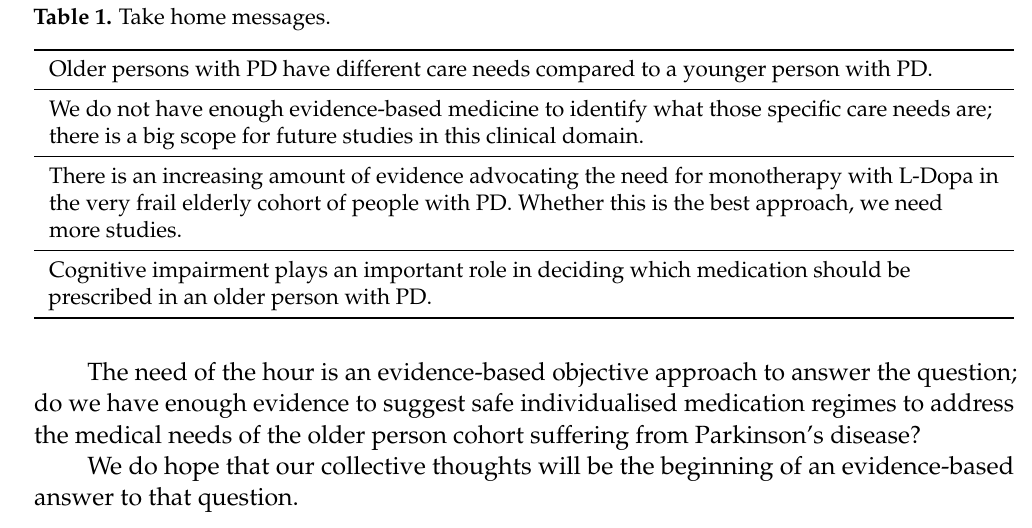
Table 1. Take home